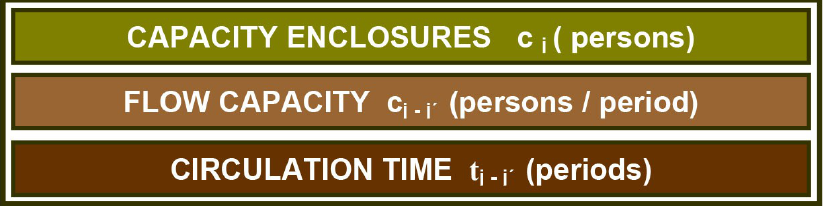
Figure 2. Basic network